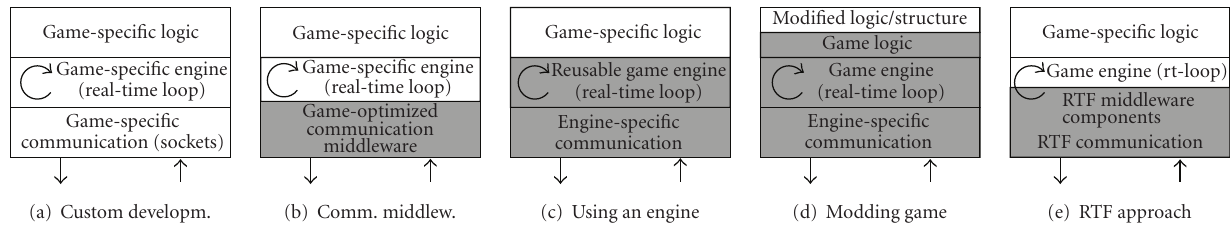
Figure 2: Main approaches to game development. White: self-developed; Gray: using existing